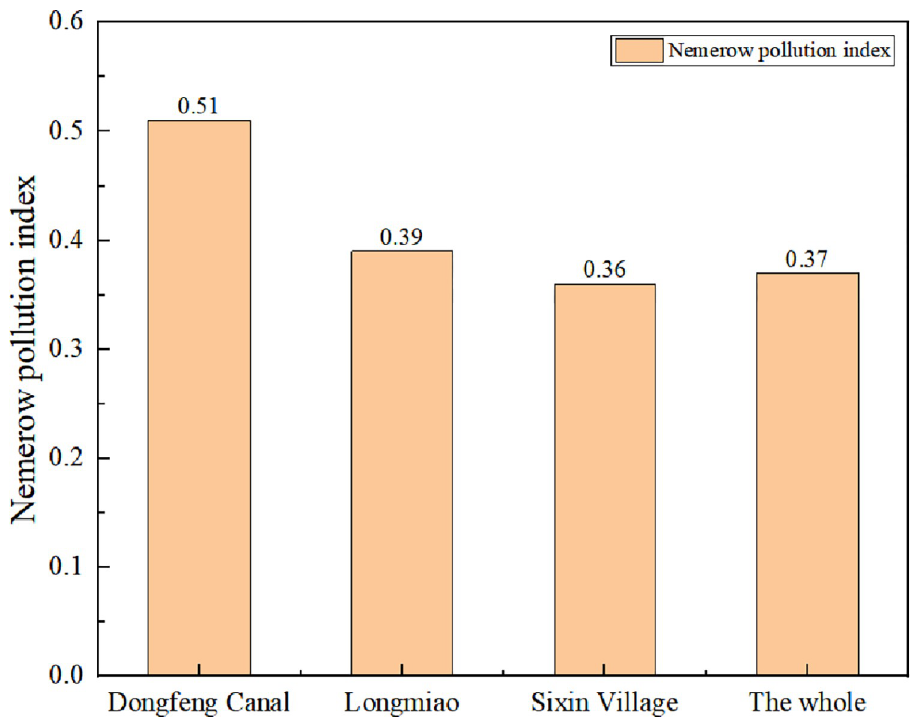
Fig 3. Comparison of Nemerow pollution index of various monitoring sections of Heilongtan Reservoir in 2020.